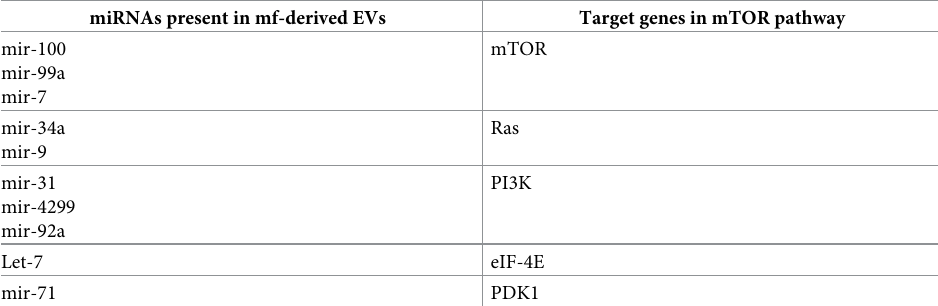
Table 2. EV miRNAs with potential target genes in the mTOR pathway.